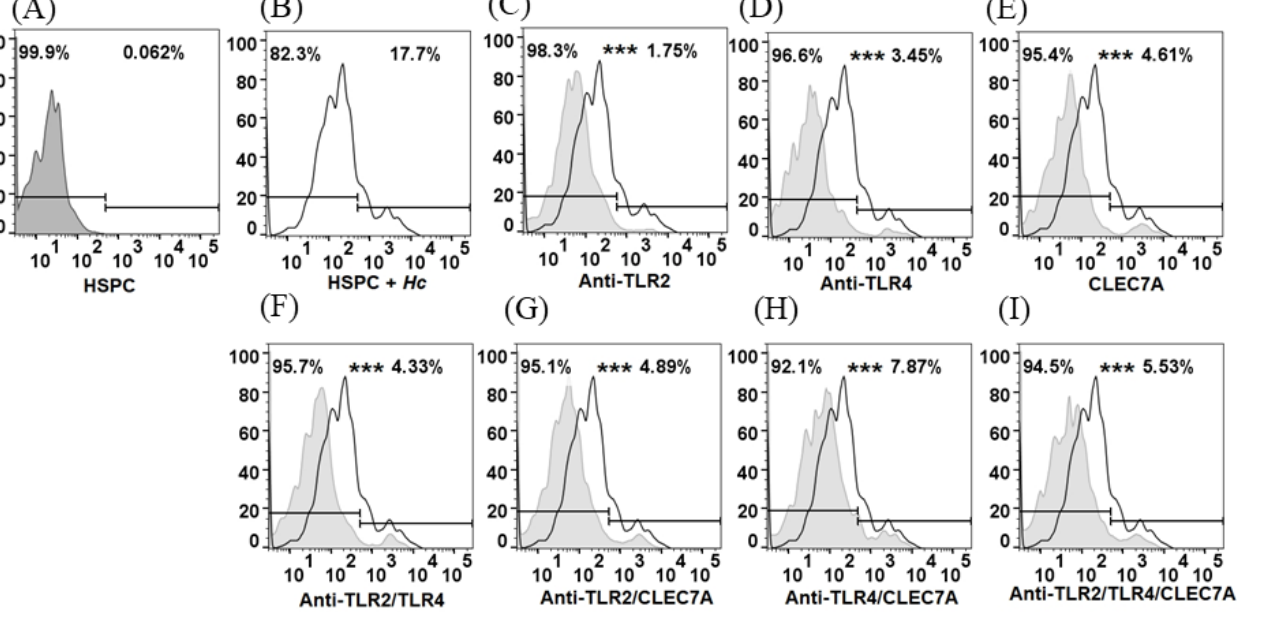
Figure 3. Phagocytosis of H. capsulatum yeasts by HSPC. Phagocytosis was analyzed by flow cytom- etry and the result is expressed as the percentage of FITC positive cells (% phagocytosis) of HSPC cells infected with H. capsulatum yeasts. ( A ) Control, HSPC ( B ) Control, percentage of phagocytosis in HSPC co-cultured with H. capsulatum and without treatment; ( C ) percentage of phagocytosis in HSPC treated with anti-TLR2; ( D ) percentage of phagocytosis in HSPC treated with anti-TLR4; ( E ) percentage of phagocytosis in HSPC treated with the peptide CLEC7A; ( F ) percentage of phagocy- tosis in HSPC treated with the anti-TLR2/anti-TLR4 combination; ( G ) percentage of phagocytosis in HSPC treated with the anti-TLR2/CLEC7A combination; ( H ) percentage of phagocytosis in HSPC treated with the combination of anti-TLR4/CLEC7A, and ( I ) percentage of phagocytosis in HSPC treated with the combination of anti-TLR2/anti-TLR4/CLEC7A. Histograms in gray correspond to HSPC previously treated with blocking antibodies for TLR or with a specific peptide for Dectin-1 (CLEC7A). Data are representative from an experiment of three replicates; *** p < 0.0001.